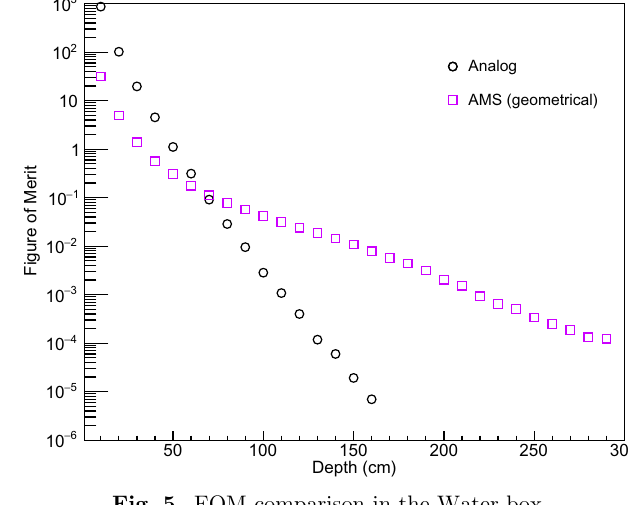
Fig. 5. FOM comparison in the Water box.